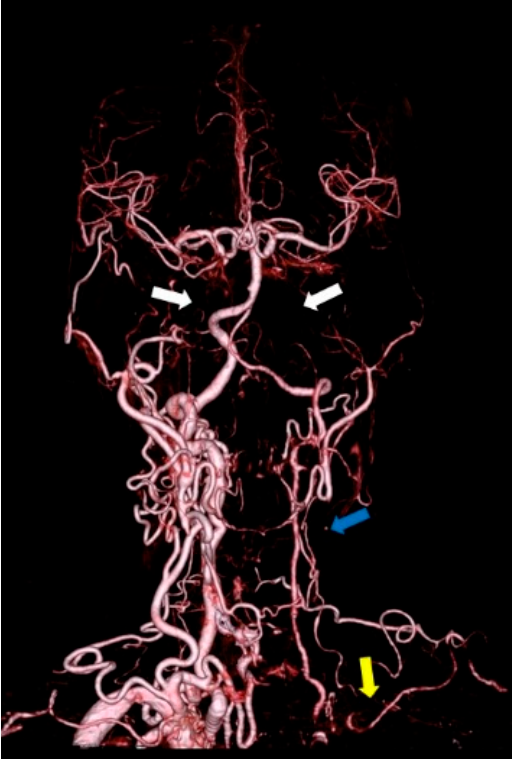
Figure 1. CTA of a 66-year-old woman with TA showing occlusion of the bilateral internal carotid arteries (white arrow), left CCA (blue arrow), and left subclavian artery (yellow arrow).